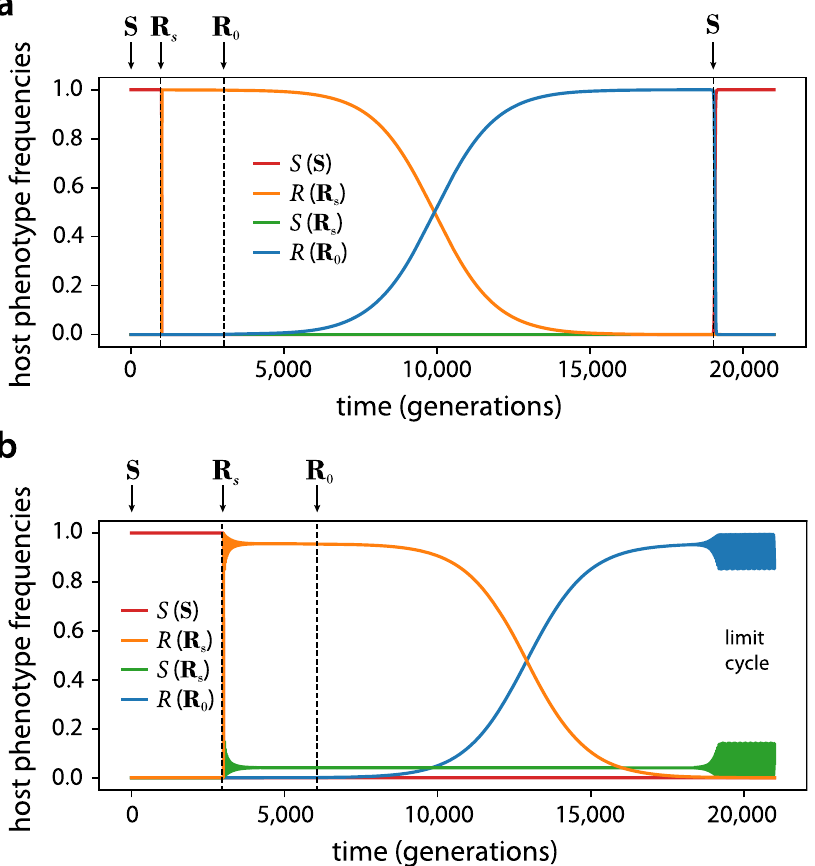
Fig. 4 Invasion dynamics for (a) preventative and (b) immune defense systems showing phenotype frequencies in the host population. Arrows indicate times at which an invading strain is added to the population. We label by R ( R s ) and R ( R 0 ) the resistant phenotype of each strain separately, and similarly by S ( R s ) and S ( S ) the sensitive phenotypes. The resistance switching strain R s outcompetes the sensitive strain S as it carries phage which lyse sensitive cells. In (a), R 0 invades and eventually replaces R s , and can then be invaded by S . In (b), R 0 invades R s , replacing the switching R phenotype while coexisting with the S phenotype of the R s strain and its phage. The RSP fi xed point, which was stable for the R s strain, is unstable for the R 0 strain and the dynamics transitions to a stable limit cycle. The model uses turbidostat control with s = 10 − 3 , α = 10, β = 50; all remaining parameters are as in Fig.